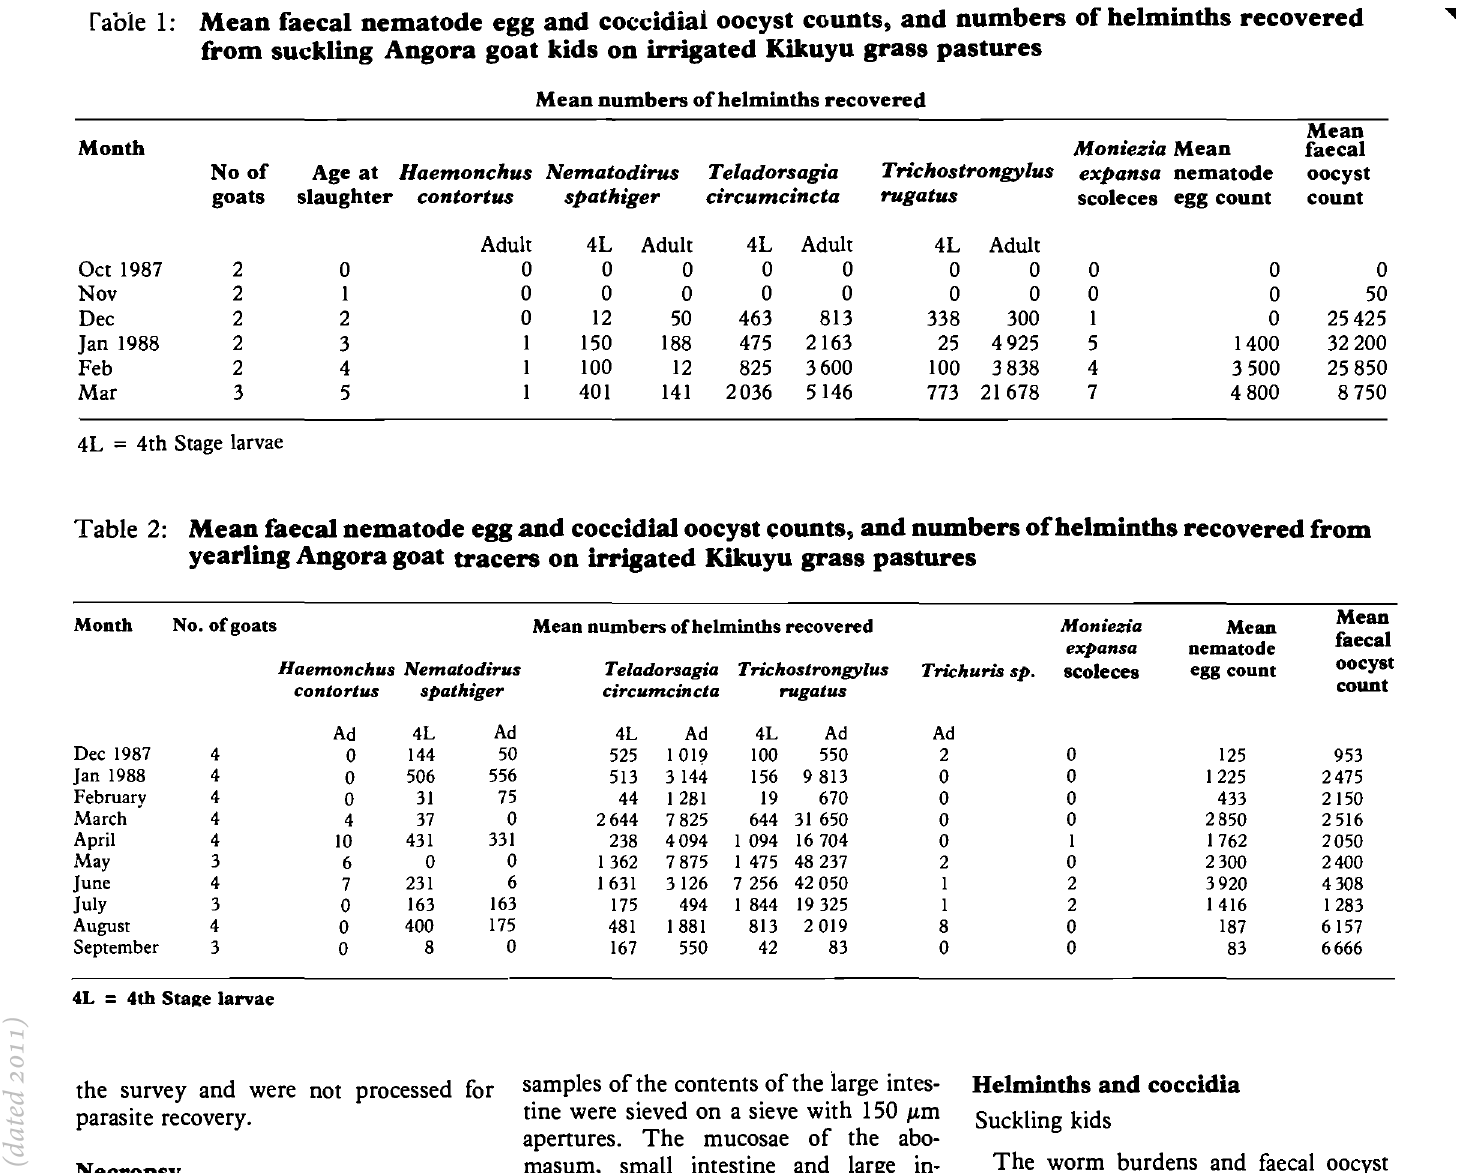
rable 1: Mean faecal nematode egg and coccidiai oocyst counts, and numbers of helminths recovered from suckling Angora goat kids on irrigated Kikuyu grass pastures